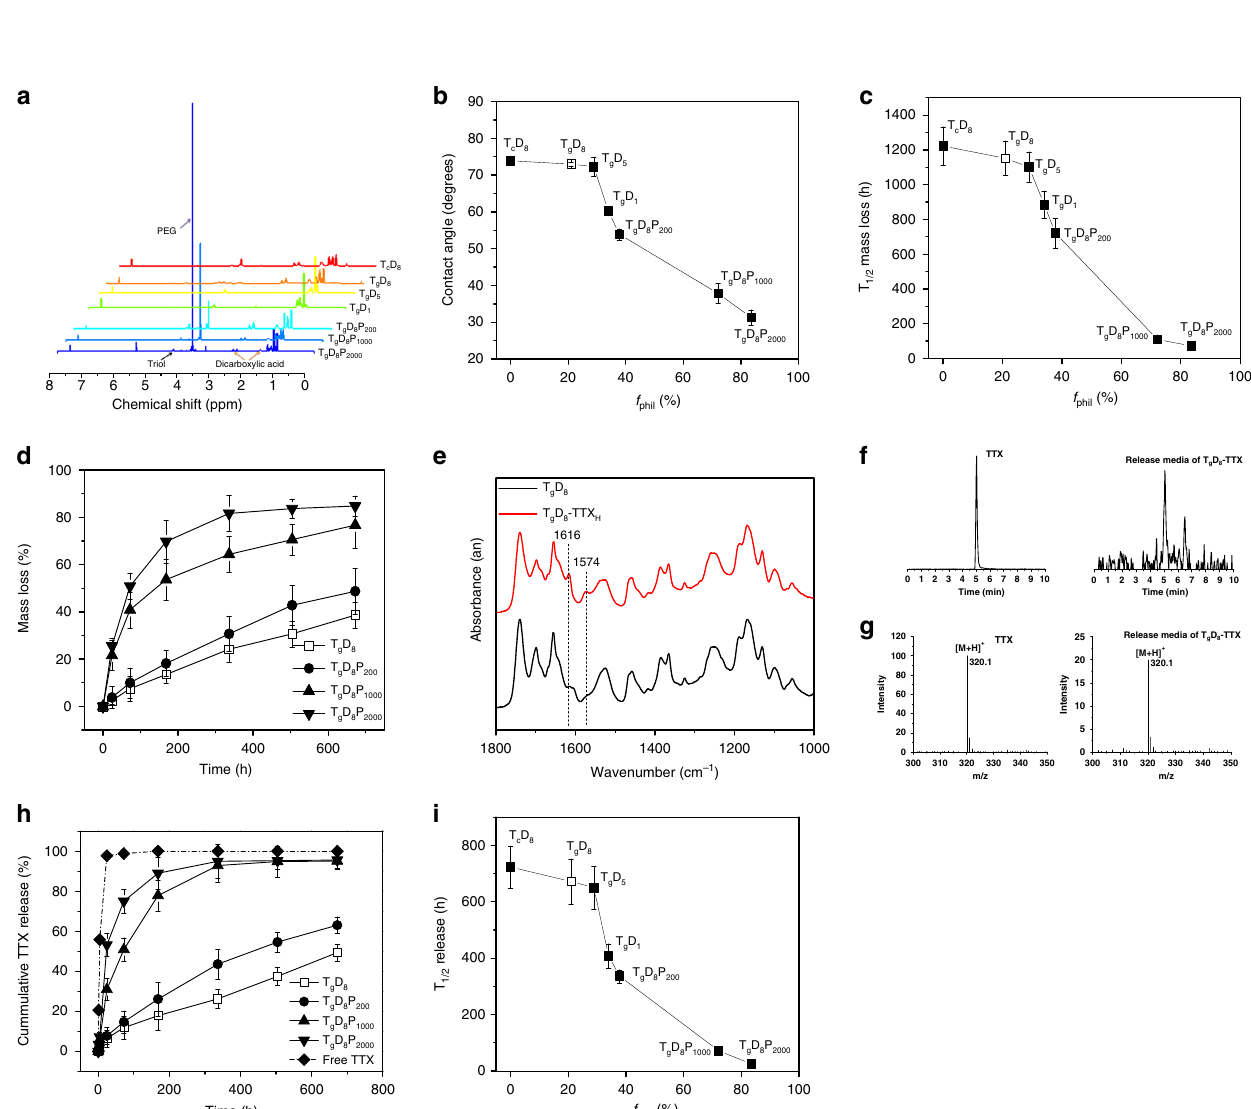
Fig. 2 Characterization of the TD/TDP polymers and their TTX conjugates. a 1 H-NMR spectra of the TD and TDP polymers. b Effect of polymer hydrophilicity ( f phil ) on contact angle of the polymer thin fi lm. c Effect of f phil on half time of mass loss. d Degradation pro fi les of the TD and TDP polymers. e FTIR spectra of the T g D 8 polymer and T g D 8 – TTX H conjugates. The guanidinium group peak is characteristic of TTX. f Total ion chromatograms of a TTX standard (10 µ g mL − 1 ) in citrate buffer and release media from T g D 8 – TTX conjugates. Both show a single peak at ~5.0 min. g Mass spectra con fi rm that the molecular weight of the peak observed at ~5.0 min corresponds to that of TTX ( m / z 320.1 is [TTX + H] + ). h Release pro fi les of 10 µ g of free TTX or TTX from TD – TTX and TDP – TTX conjugates with differing f phil . i Release half-time of 10 µ g of conjugated TTX as a function of f phil of polymer. In panels ( a – d ), ( h ), and ( i ), the open box denotes T g D 8 . Data in graphs are means± SD, n =